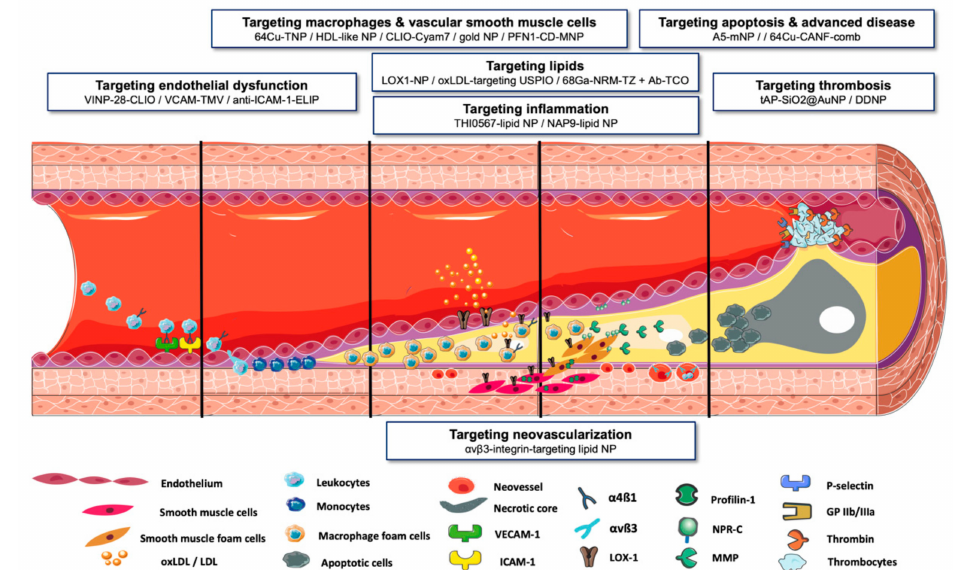
Figure 1. Take-home figure. Molecular targets on di ff erent stages of atherogenesis: (VINP-28-MNP) VCAM-1-targeting magneto-fluorescent NP [14] (VCAM-TMV) VCAM-1-targeting modified tobacco mosaic virus [15] (anti-ICAM-1-ELIP) ICAM-1-targeting echogenic liposomes [49] ( 64 CU-TNP) paramagnetic, positron-emitting, fluorescent targeted iron oxide NP [17] (HDL-like NP) HDL-like multimodality NP [20] (CLIO-Cyam7) crosslinked iron oxide, derivatised with Cyam7 for near infrared fluorescenceimaging[47] (goldNP) CD163-targetinggoldNP[18] (PFN1-CD-MNP) profilin-1-targeting magneto-fluorescent nanoparticle [23] ( α v β 3-integrin-targeting lipid NP) micellar nanoparticle bearing gadolinium and a peptidomimetic RGD-sequence binding α v β 3-integrin [27] (LOX1-NP) liposomal NP coupled with an anti-LOX-1-antibody, containing a fluorescent dye and either gadolinium or indium 111 [32] (oxLDL-targeting USPIO) ultrasmall superparamagnetic iron oxide NP conjugated to anti-mouse oxLDL-antibodies [33] ( 68 Ga-NRM-TZ + Ab-TCO) paramagnetic, positron-emitting nano-radiomaterial connected via tetrazine ligation to antibody against oxidized phospholipids [34] (THI0567-lipid NP) liposomal NP bearing gadolinium, selective integrin α 4 β 1 antagonist THI0567 and rhodamine [28] (NAP9-lipid NP) paramagnetic micellar NP conjugated with gadolinium, rhodamine and EMMPRIN-specific binding peptide NAP9 [30] (A5-mNP) micellar NP bearing Cy5.5 and rhodamine, gadolinium and polymers, covalently coupled to phosphatidylserine ligand annexin A5 [36] ( 64 Cu-CANF-comb) NPR-C-targeting polymeric positron-emitting nanoparticle (TAP-SiO2@AuNP) gold NP coated with silicon dioxide linked to a thrombin-activatable fluorescent peptide [39] (DDNP) NP based on paramagnetic iron oxide and Indian ink linked to cRGD- and GA-EWVDV-ligands targeting glycoprotein IIb / IIIa and P-selectin on activated platelets